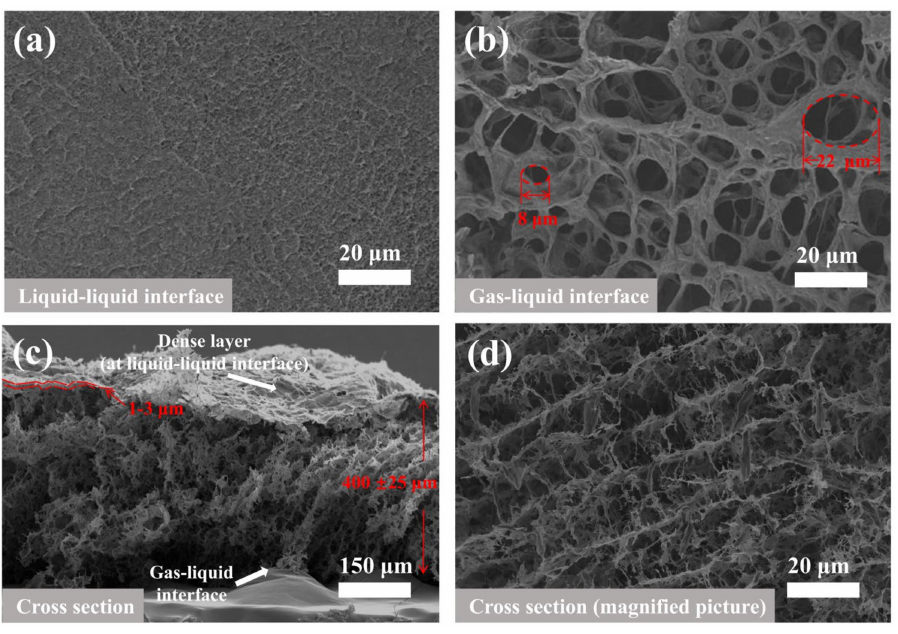
Figure 4. SEM images of ( a ) liquid–liquid interface; ( b ) gas–liquid interface; ( c ) cross section; ( d ) mag- nified cross section of the CCM.